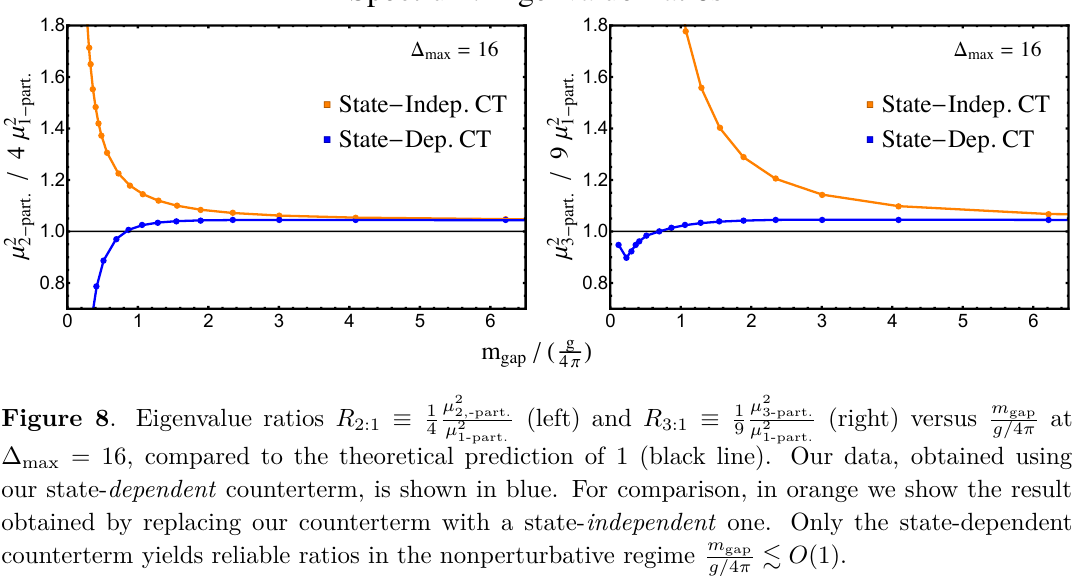
µ 2 2 , -part. µ 2 3 -part. (left) and R (right) versus m gap at 1 3:1 ≡ 4 9 g/ 4 π µ 2 1 -part. µ 2 1 -part. . O (1) g/ 4 π